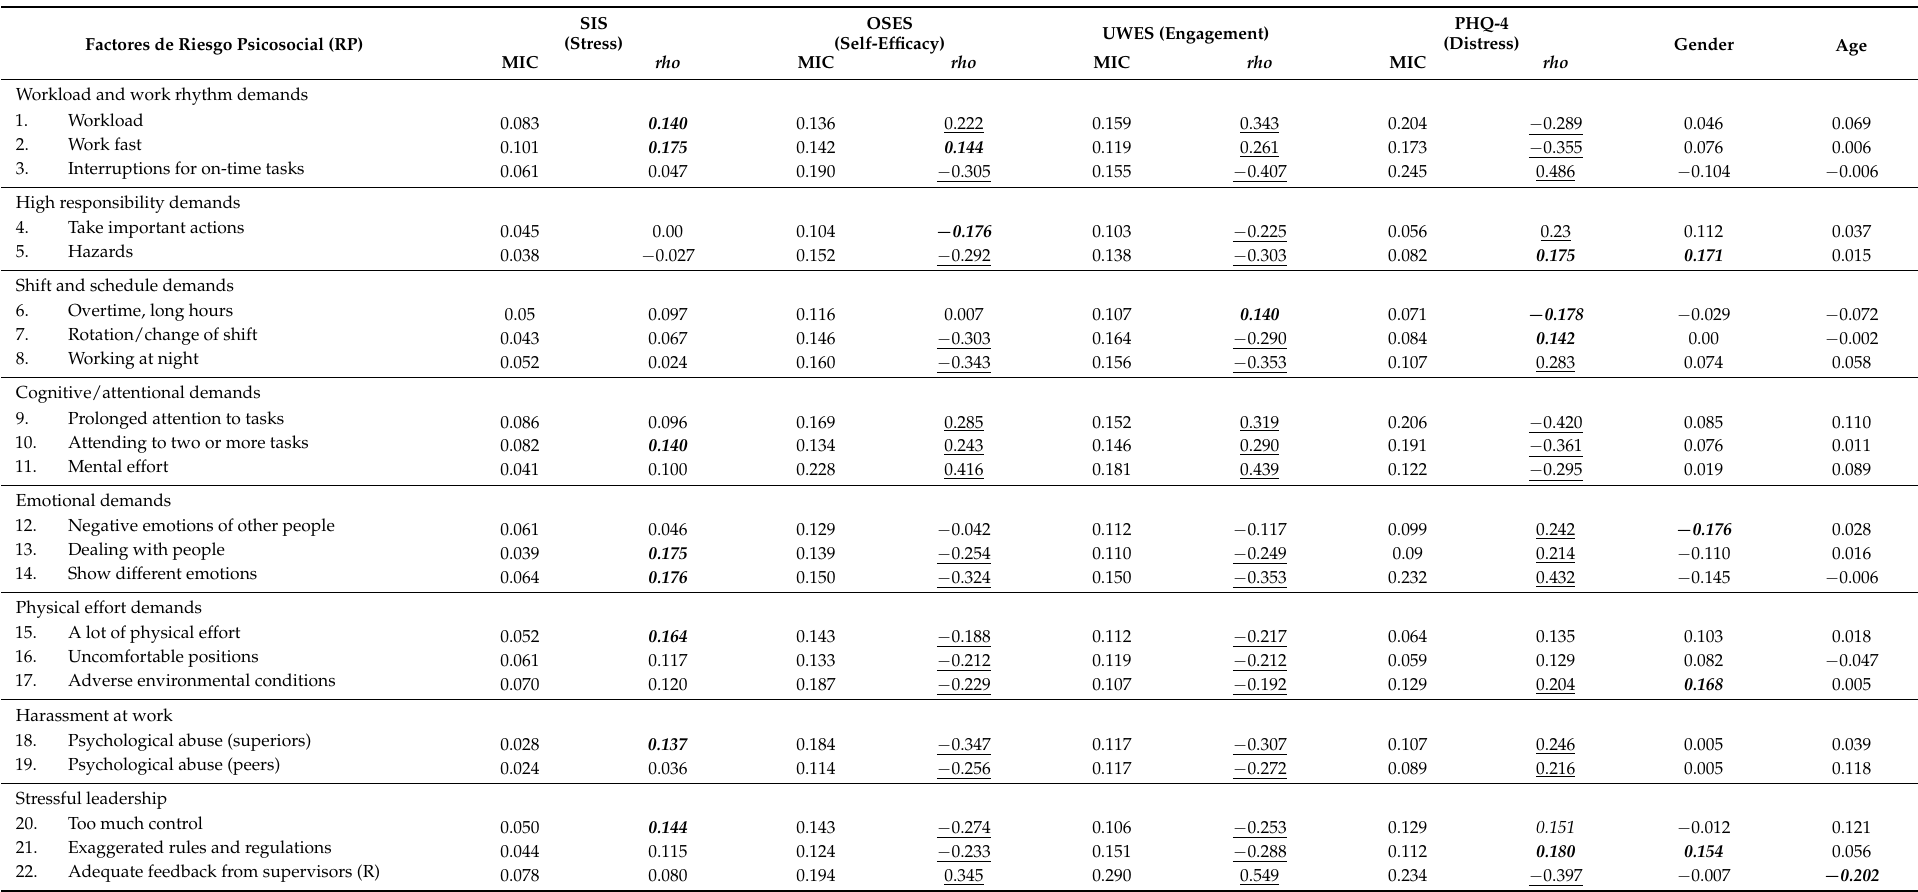
Table 4. Associative results of the psychosocial risk factor